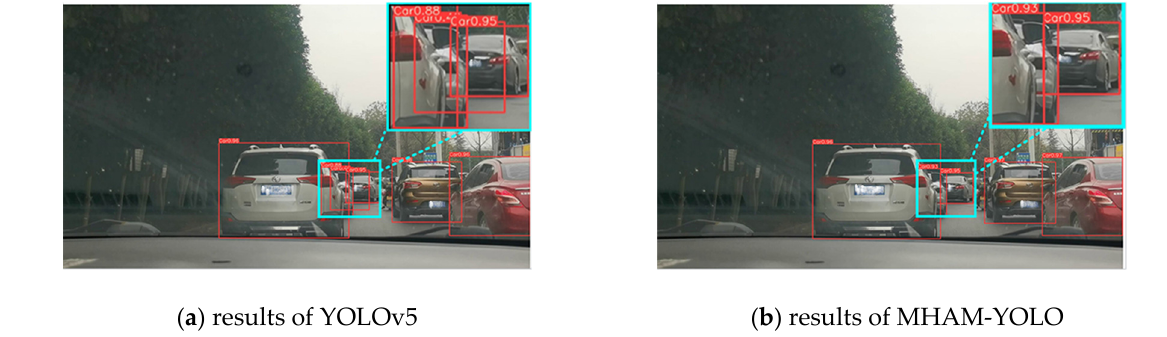
Figure 10. Comparison of the detection effect of vehicle obstruction.